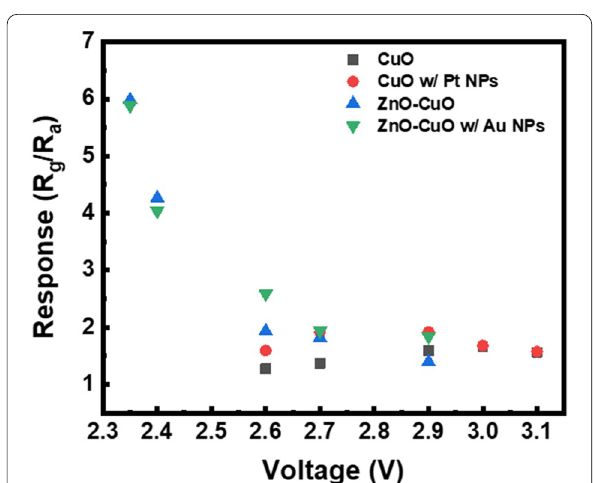
Fig. 5 Response of MEMS sensor arrays for acetone 1 ppm as a function of applied